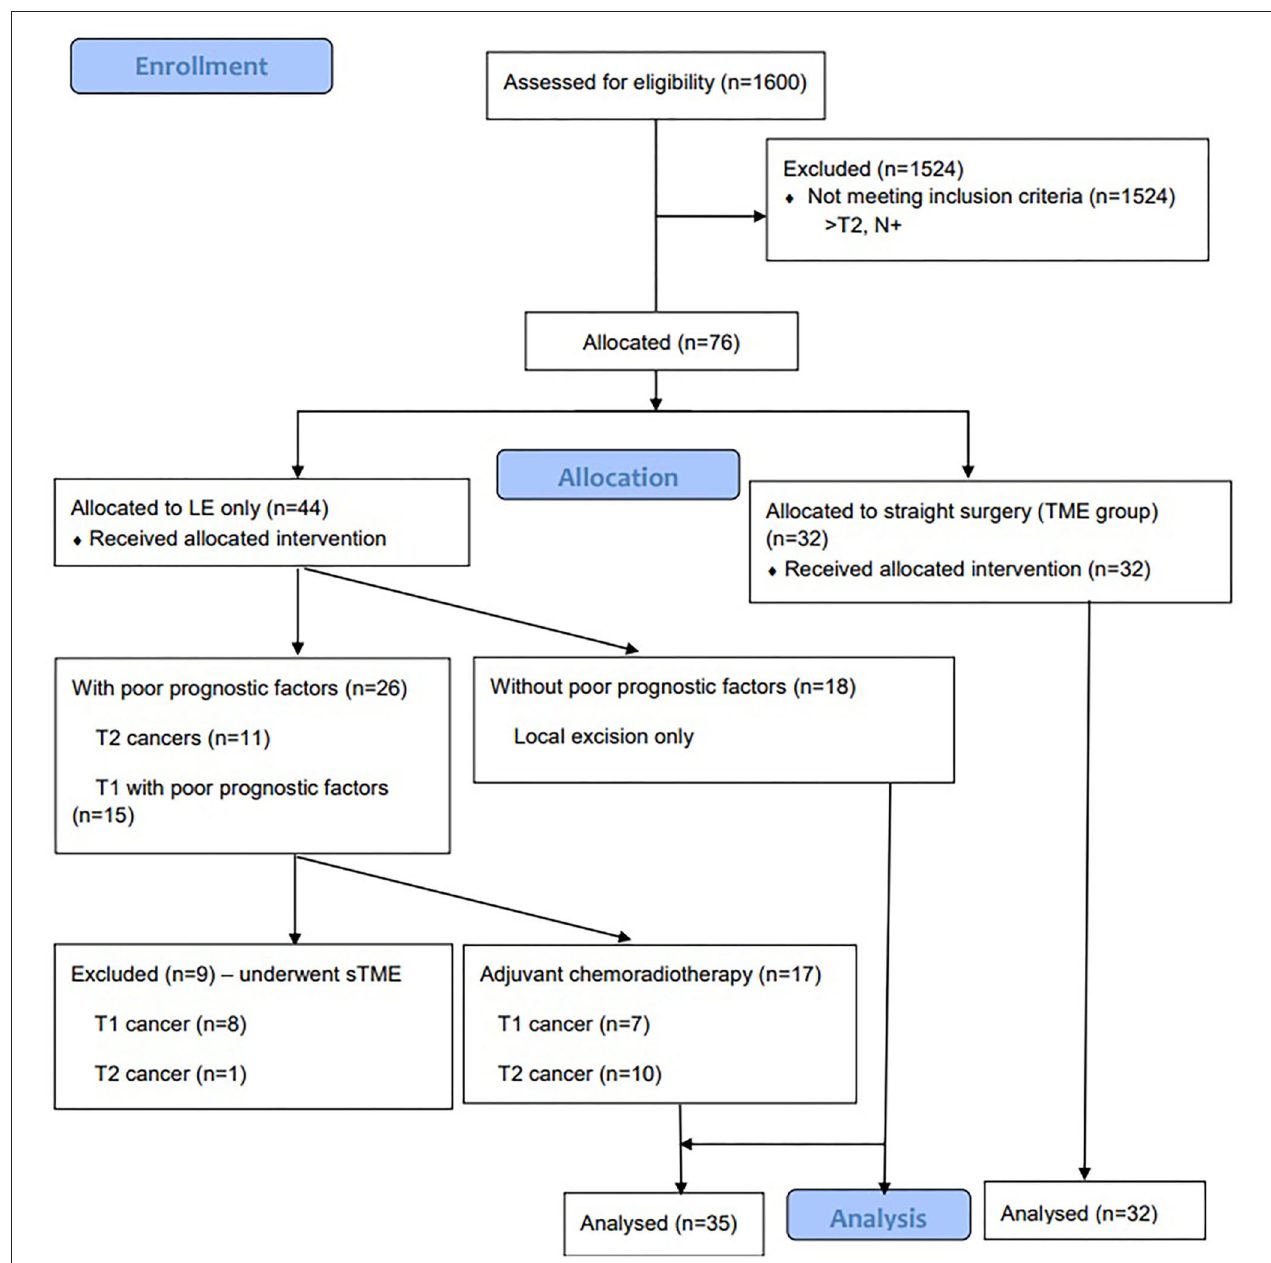
FIGURE 1 | Consort Flow Diagram of patients undergoing local excision with or without chemoradiotherapy vs total mesorectal excision for early rectal cancer.